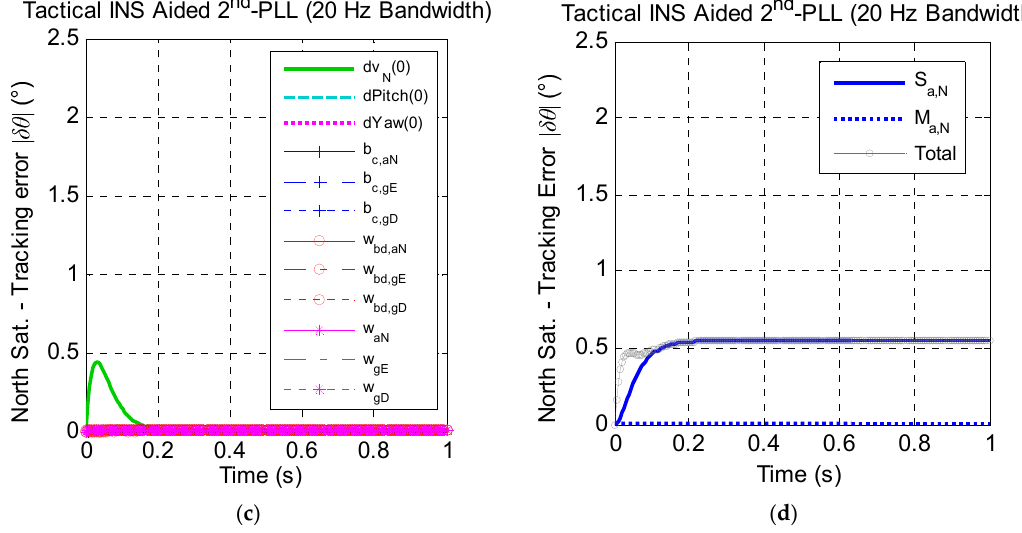
Figure 6. The north satellite tracking error caused by tactical INS error sources under the assumption of linear high dynamics along the north direction. ( a ) Effect of non-maneuver-dependent error with a 10-Hz bandwidth; ( b ) effect of maneuver-dependent error with a 10-Hz bandwidth; ( c ) effect of non-maneuver-dependent error with a 20-Hz bandwidth; ( d ) effect of maneuver-dependent error with a 20-Hz bandwidth. (* Here, Sat. is the abbreviation of